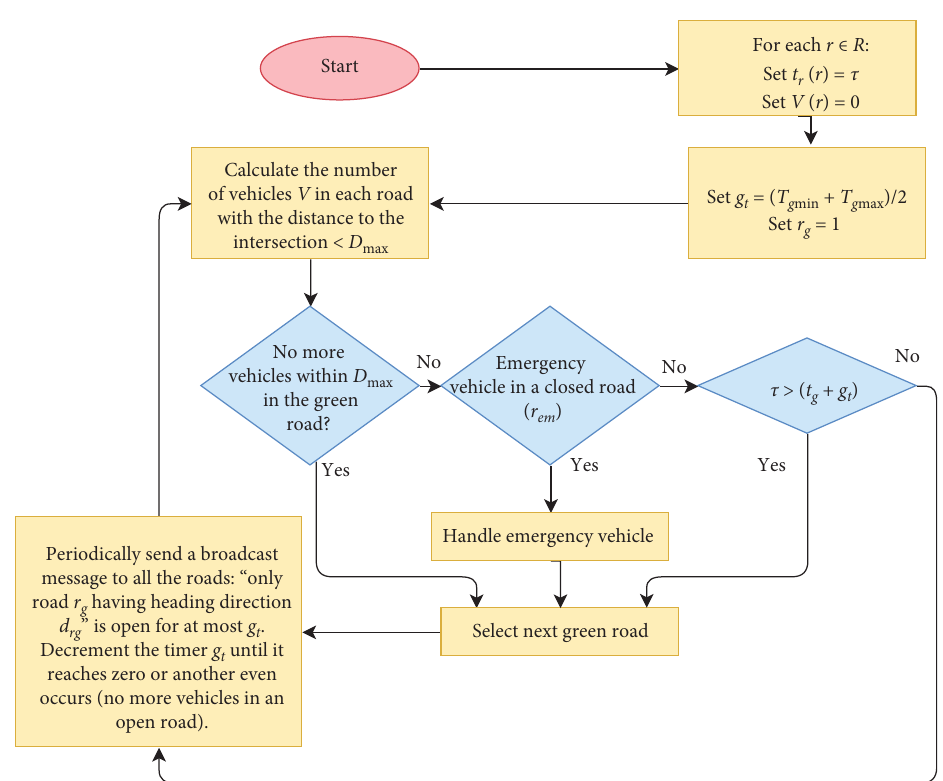
Figure 8: Flowchart of the overall proposed adaptive traffic management